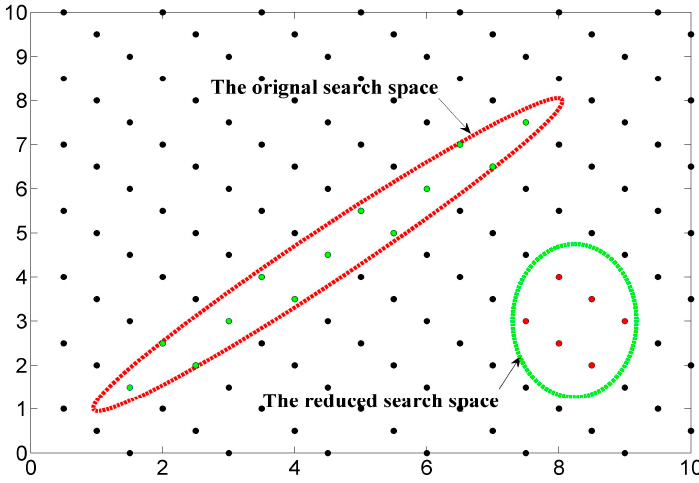
Figure 2. The effect of lattice reduction on the searching space.